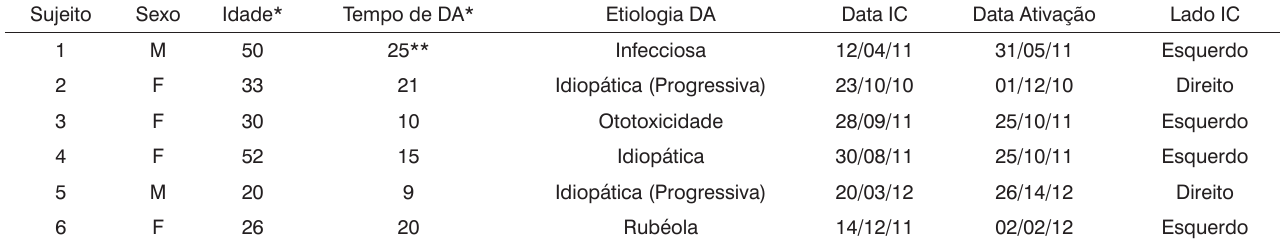
Tabela 2. Dados gerais dos casos implantados.